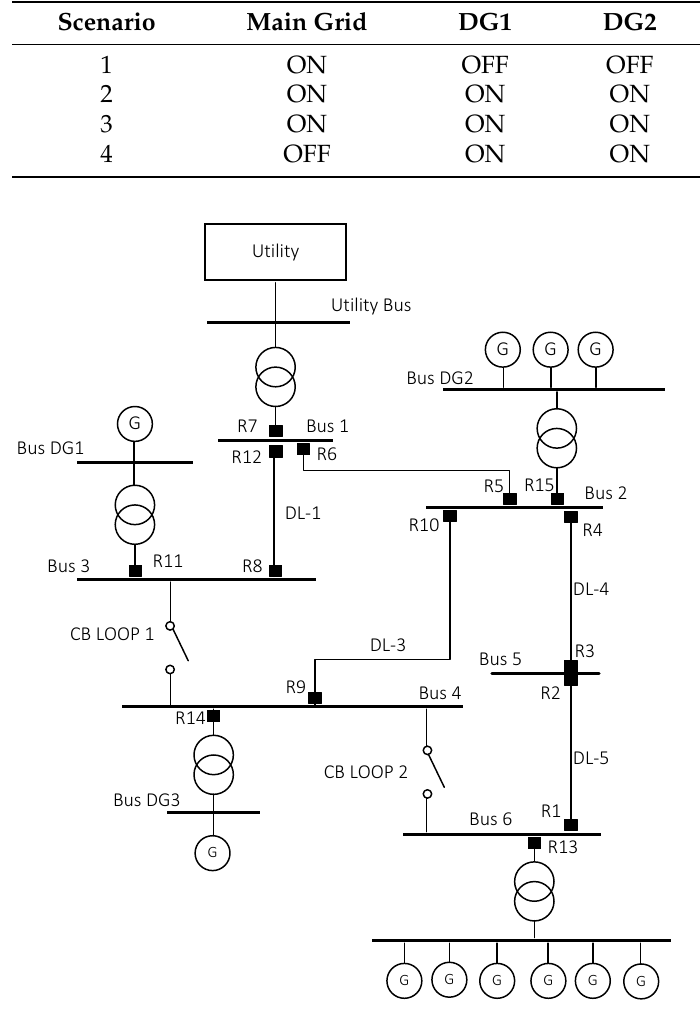
Figure 3. Distribution network with DG (adapted from [21]). Five three-phase line failures were considered. In this case, fault 1 represents a fault on line DL-5; Fault 2 and Fault 3 are failures on lines DL-4 and DL-2, respectively; fault 5 represents a fault on the DL-1 line; and F5 represents a fault on the DL-3 line. The results obtained with the proposed approach were compared with those reported in